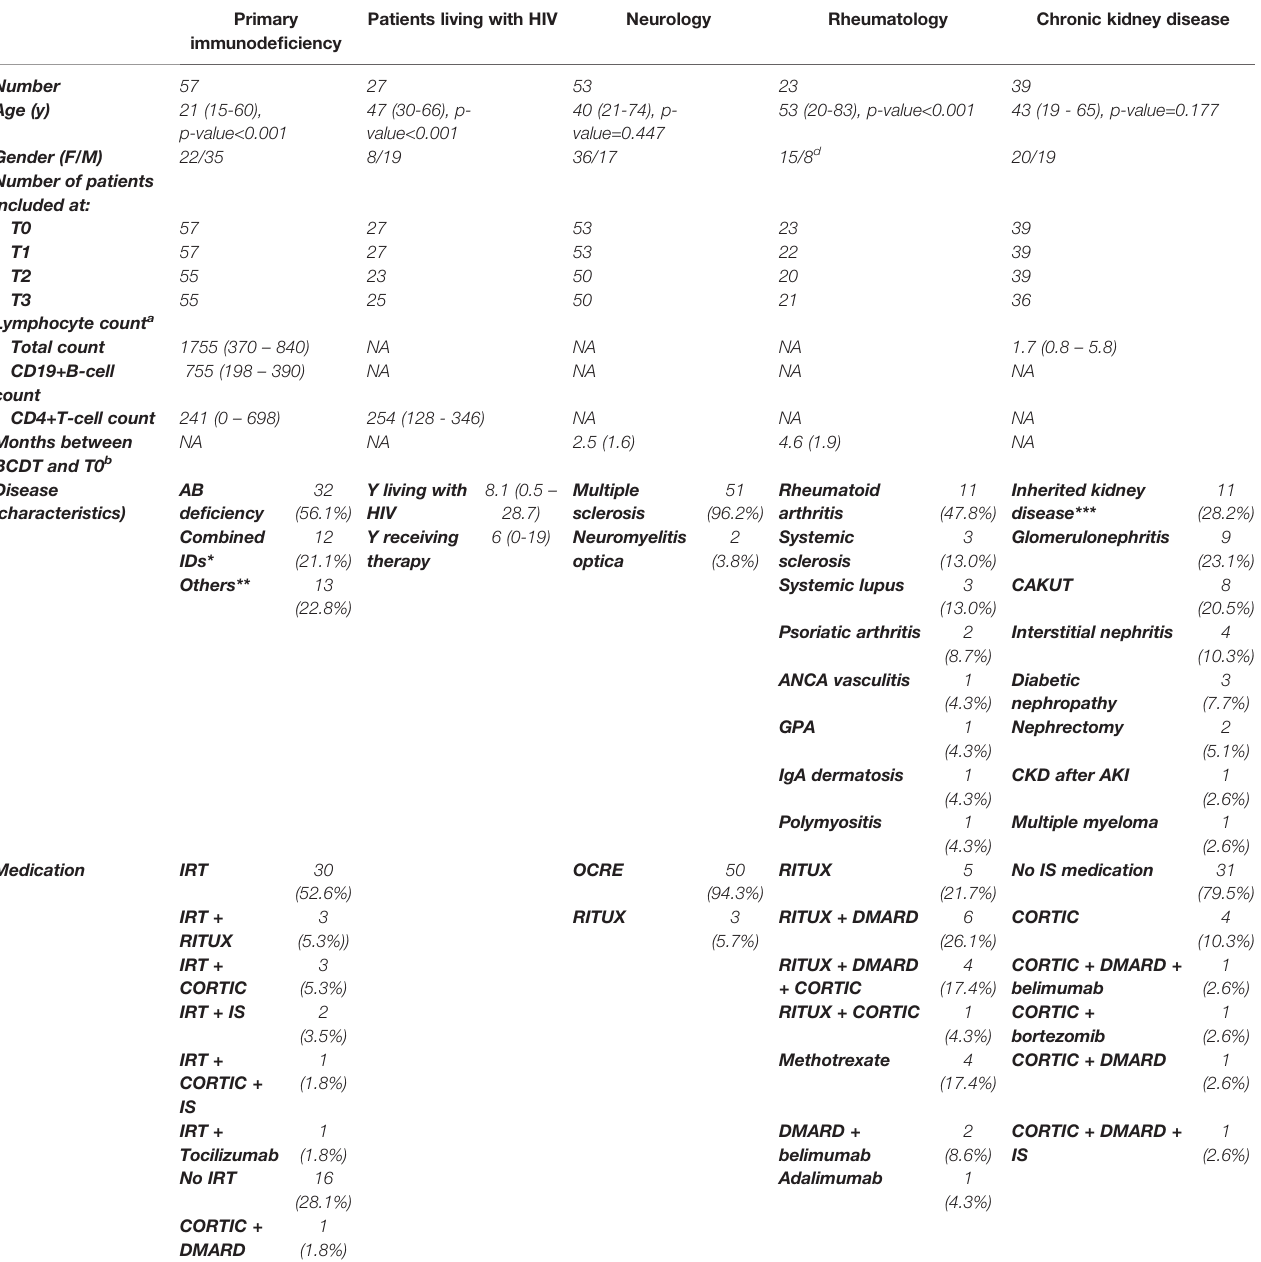
TABLE 1 | Characteristics of the different patient groups included in the